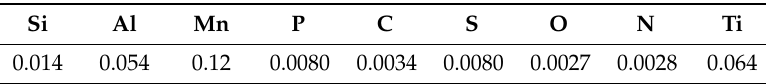
Table 1. Chemical compositions of the experimental